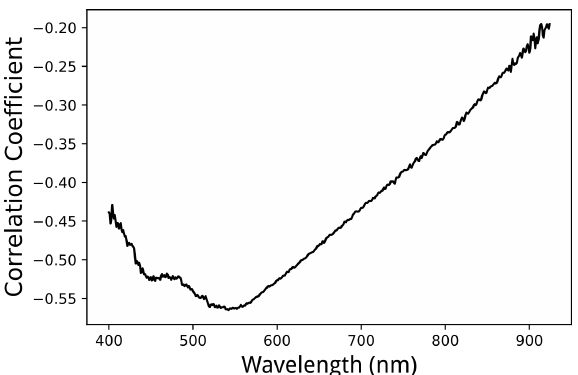
Figure 6. Correlation coefficient between individual spectral curves and TC. This graph shows the negative correlation between soil carbon content and soil reflectance. The higher correlation occurs near 550 nm.